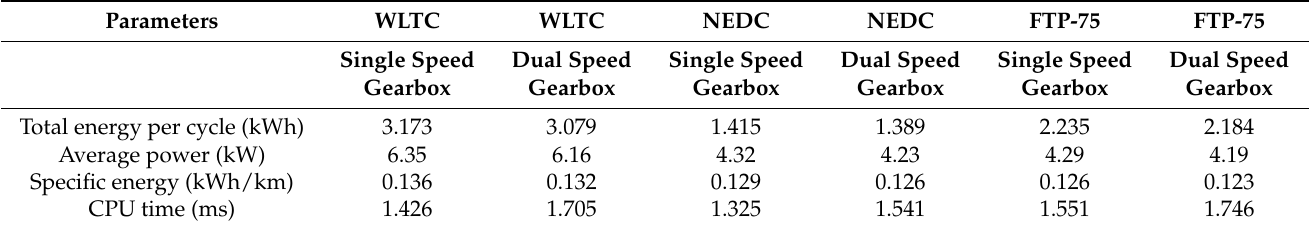
Table 4. Energy consumption and computational